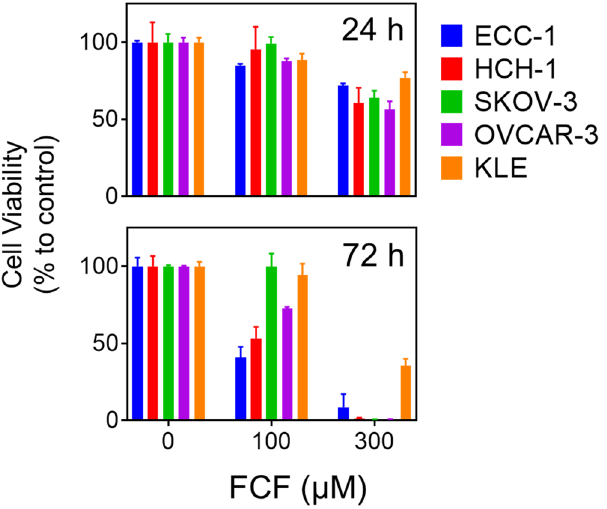
Figure 1. The effect of FCF on the viability of ovarian and endometrial cancer cell lines. Cancer cell lines were treated with FCF (0, 100, 300 µ M) for either 24 h or 72 h, after which the cell viability was measured by MTS